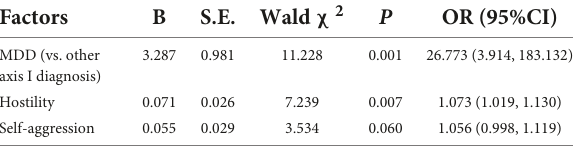
TABLE 3 Results of the multivariate logistic regression analysis on the factors correlated with SA in BPD patients.